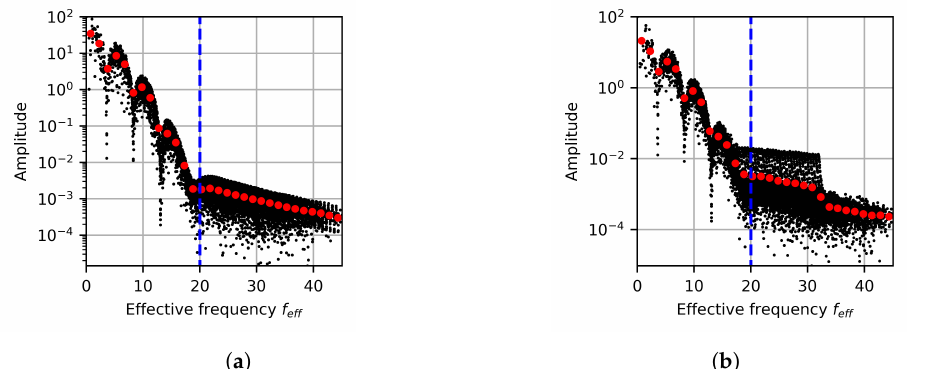
Figure 10. A 1D projection of the FFT data of the ( a ) four and ( b ) nine randomly placed circles. The dashed blue line indicates the HFLS.